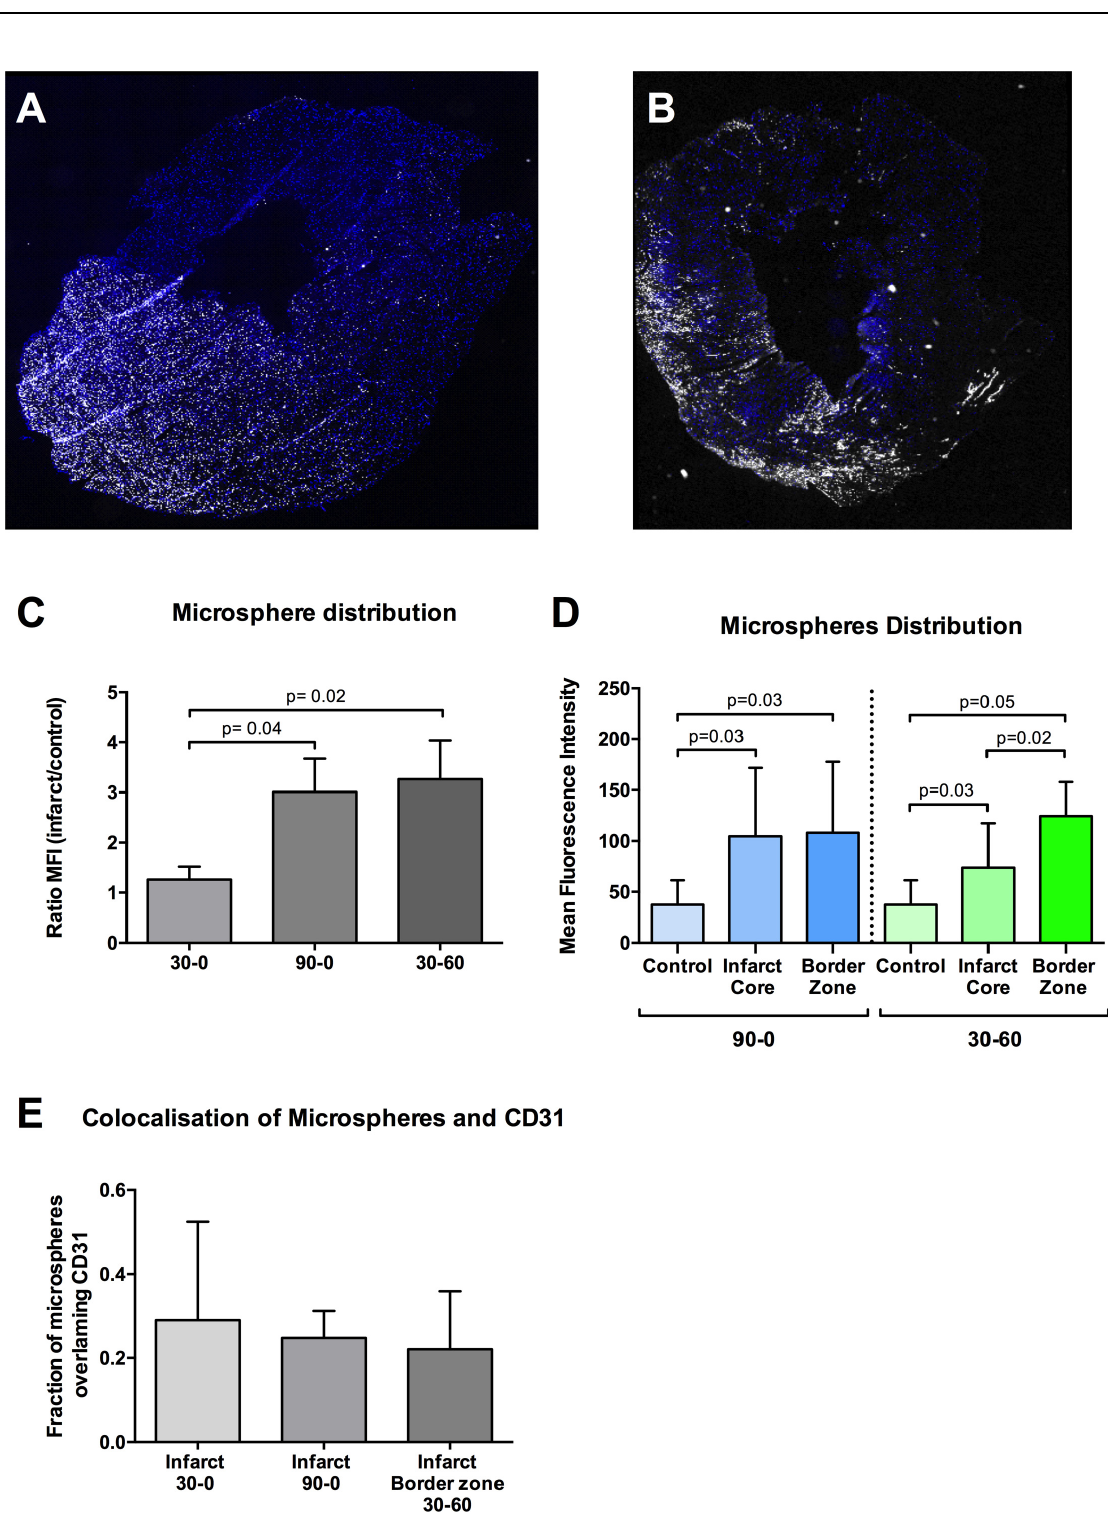
Fig 1. Distribution of fluorescent microspheres. A-B Images of transverse slices of the left ventricle, showing distribution of fluorescent microspheres (white). Nuclei are stained with Hoechst (blue). Red arrow: infarct zone, asterisk: control zone. A-B represents group 90 – 0 and 30 – 60 respectively. White bars represent 1mm. C Distribution of MFI within the 90 – 0 and 30 – 60 group D Mean fluorescent intensity (MFI) of fluorescent microspheres, expressed a ratio between infarct area and control area. E Pixel-based colocalisation analysis of fluorescent microspheres and CD31 positive tissue for extravasation.